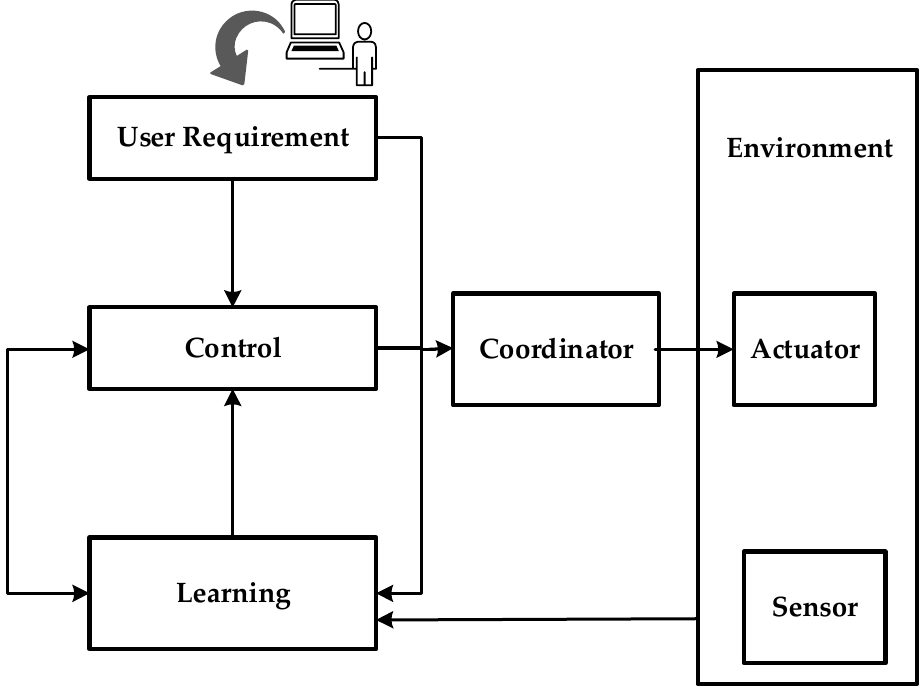
Figure 1. Conceptual learning-to-control model.